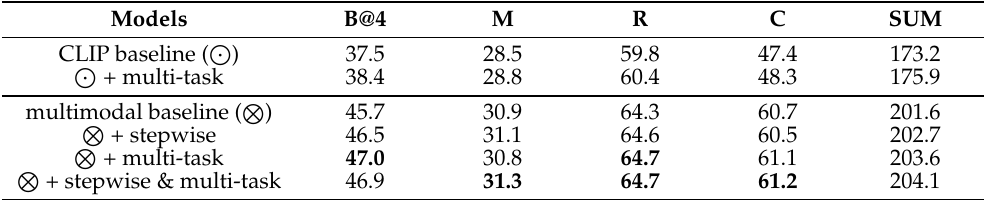
Table 3. Compared results without multi-task or stepwise design on the MSR-VTT dataset. SUM represents the sum of four metrics. The maximum value of each column is marked in bold. (cid:74) and (cid:78) refer to two baselines.